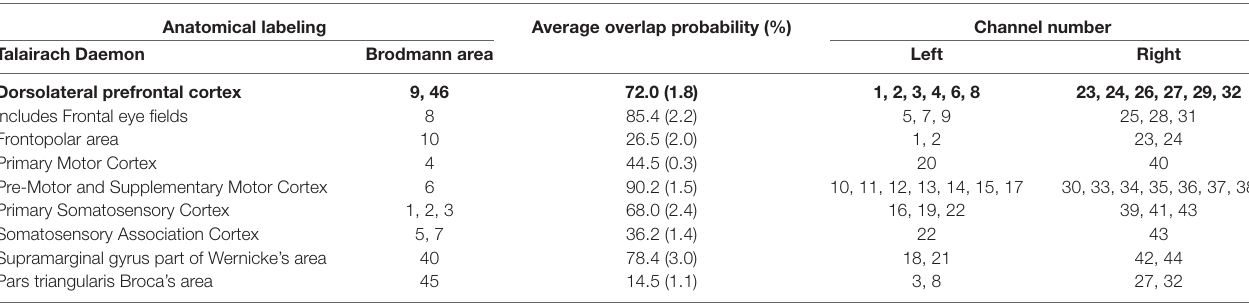
TABLE 1 | Anatomical labeling of near-infrared spectroscopy (NIRS) channel positions. Anatomical labeling Average overlap probability (%) Channel number Talairach Daemon Brodmann area Left Right Dorsolateral prefrontal cortex 9, 46 72.0 (1.8) 1, 2, 3, 4, 6, 8 23, 24, 26, 27, 29, 32 Includes Frontal eye